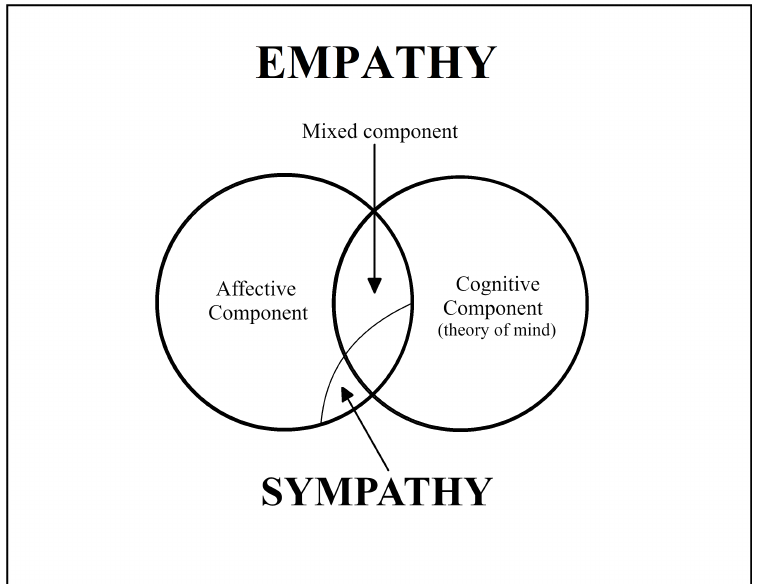
Figure 1. Simple model of empathy presented by Baron-Cohen and Wheelwright